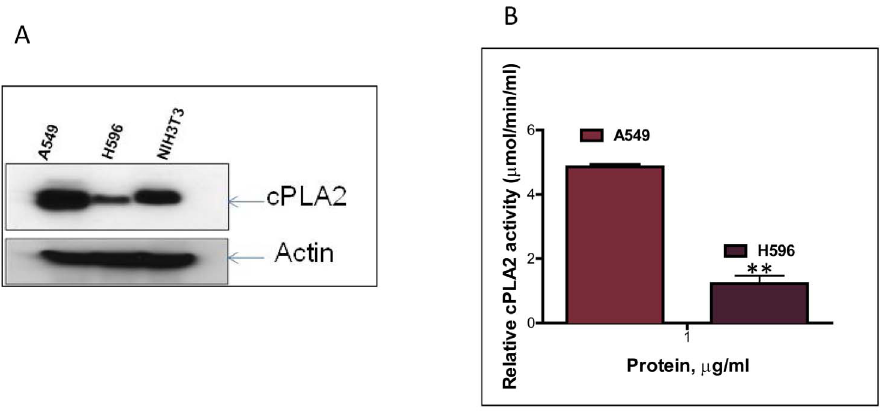
Figure 6. cPLA2 was differentially regulated in A549 and H596 cells. (A) Protein expression of cPLA2 in A549 and H596 cell was determined by Western blotting; (B) Activity of cPLA2 in A549 and H596 cells was measured as previously described. Both protein level and activity of cPLA2 were significantly lower in H596 cells compared to that of A549 cells.